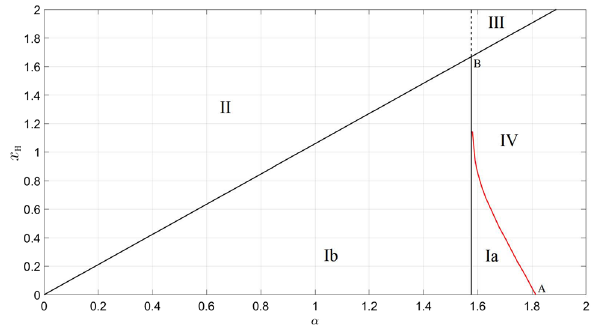
Fig. 7 ‘Phase diagram’ of black hole solution in Einstein–Weinberg– Salam theory for physical β and Weinberg angle